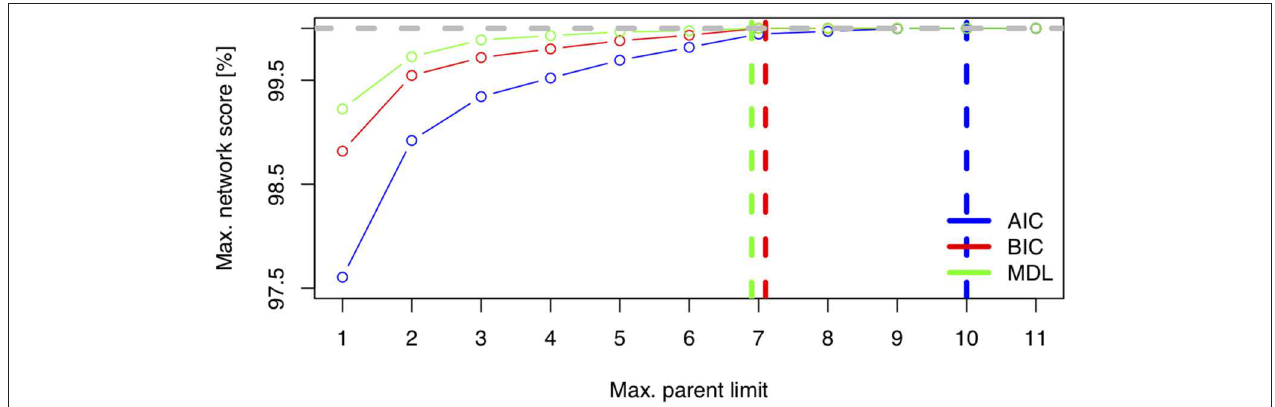
FIGURE 6 | Network score: Minimum Distance Length (MDL), Bayesian Information Criteria (BIC), and Akaike Information Criteria (AIC) as a function of network complexity, i.e., the maximum number of allowed parents per